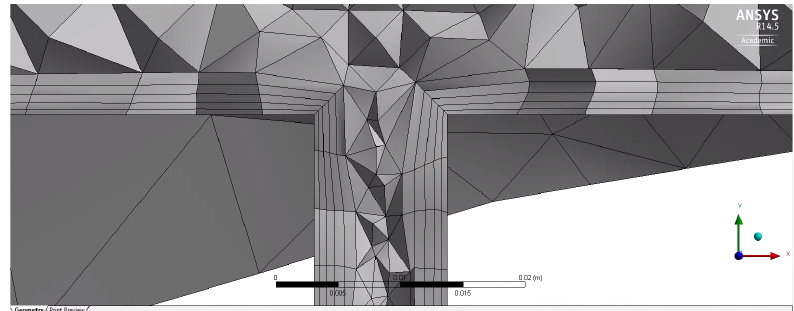
Figure 5. Local mesh near the gap.